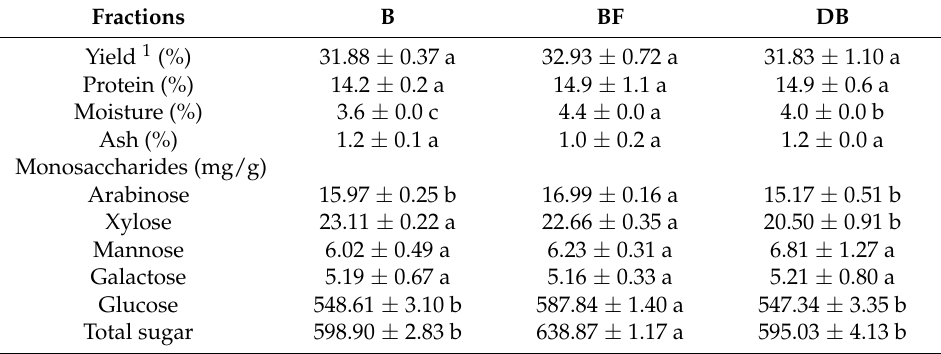
Table 1. Yields and chemical compositions of freeze dried wheat beer and its